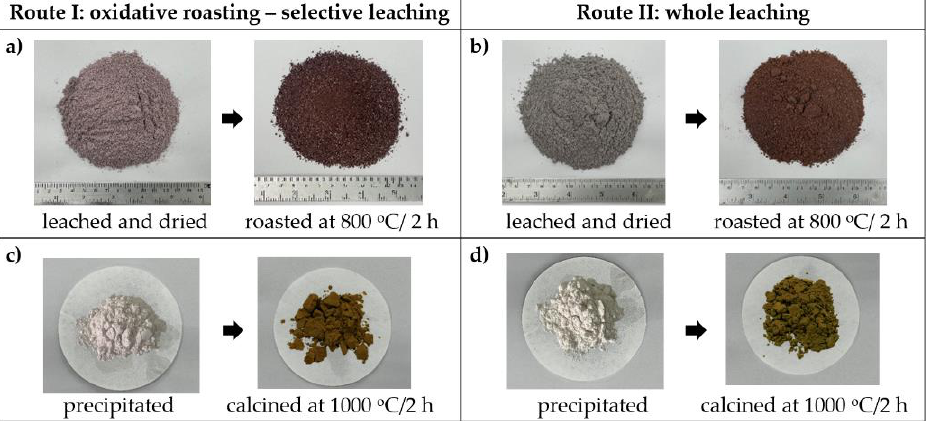
Figure 7. Products obtained via route I and route II recycling of sintered wastes, ( a , b ) after leaching, drying and roasting at 800 °C/2 h, ( c , d ) after precipitation and calcination